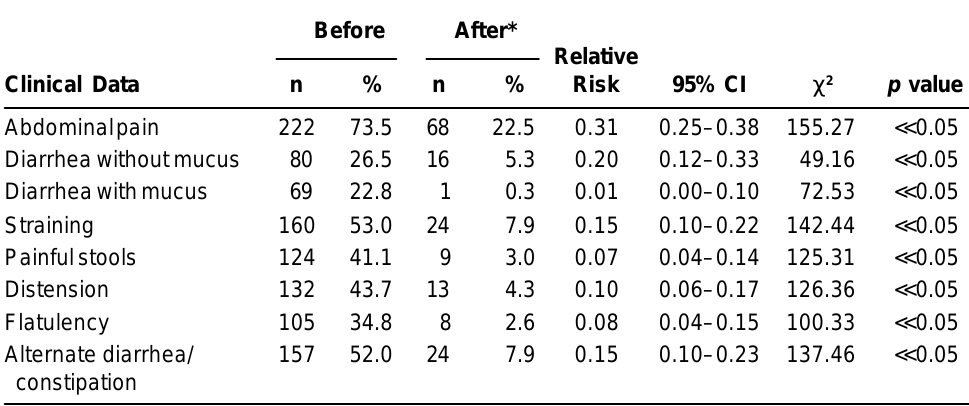
Gastrointestinal Clinical Data Before and After* the First Quinfamide Treatment Before